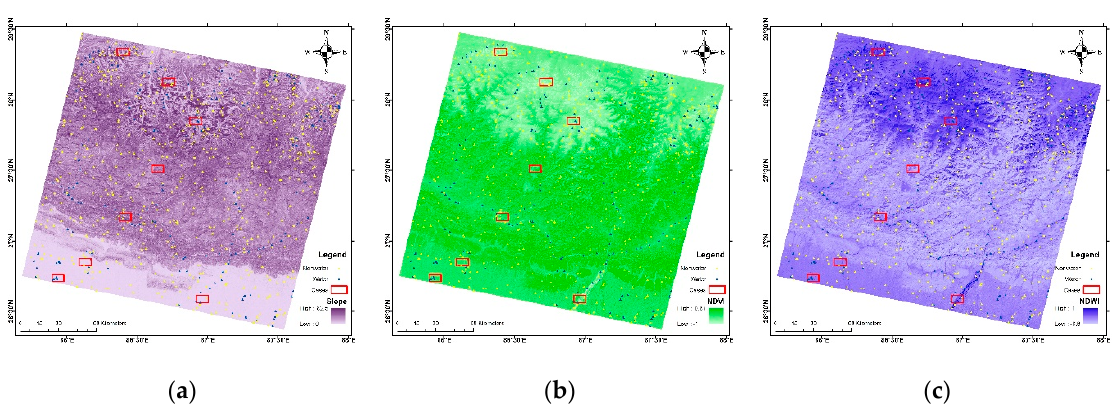
Figure 2. Secondary bands ( a ) slope; ( b ) NDVI and ( c )